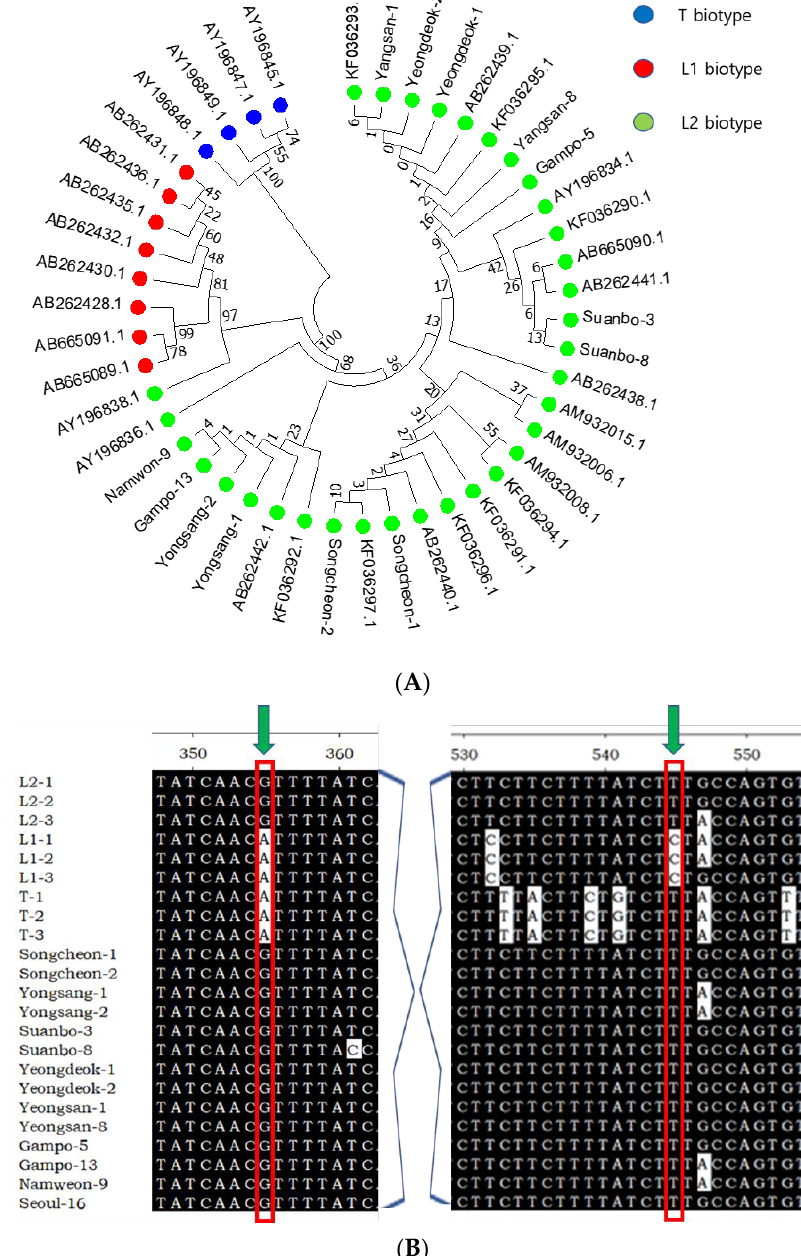
Figure 2. Biotype of T . tabaci infesting Welsh onion in Korea. ( A ) Phylogeny tree analysis of 12 individuals from different local populations along with known biotypes: tobacco type (T biotype), arrhenotokous type (L1 biotype), and thelytokous type (L2 Biotype). The tree was generated by the Neighbor Joining tree method using the software package MEGA6.0. The tree is drawn in evolu- tionary distances computed using the Poison correction method. Bootstrap values on nodes were obtained by 1000 repetitions. Individuals are denoted with GenBank accession numbers. ( B ) Con- served nucleotide sequences (red rectangle) that are characteristics of the L2 biotype.